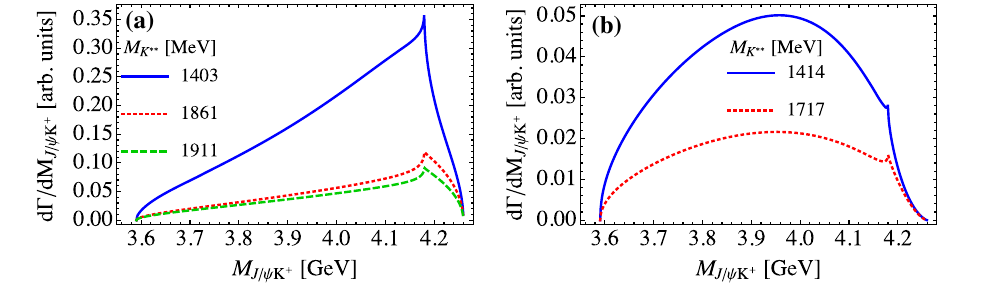
Fig. 5 Invariant mass distribution of J /ψ K + via the rescattering pro- cesses in Fig. 4. For a : The mass and width of K ∗∗ with J P = 1 + are taken to be those of K 1 ( 1400 ) (solid line), K ( 1860 ) (dotted line), and